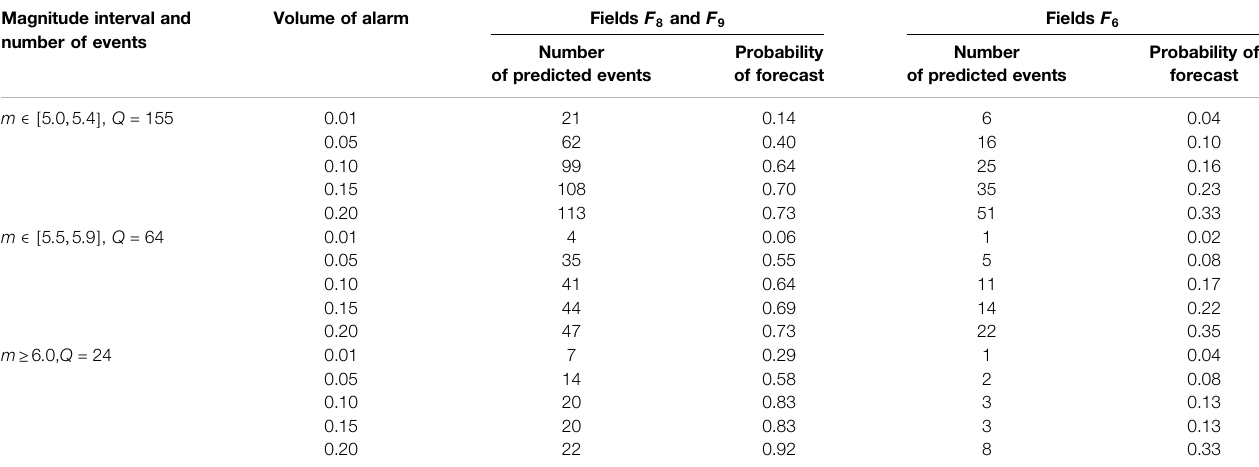
TABLE 1 | Kamchatka: probabilities of forecasting the earthquakes in magnitude intervals m ∈ [ 5 . 0 , 5 . 4 ] , m ∈ [ 5 . 5 , 5 . 9 ] , m ≥ 6 . 0 (earthquake magnitudes are accurate to tenths). Magnitude interval and Volume of number of events